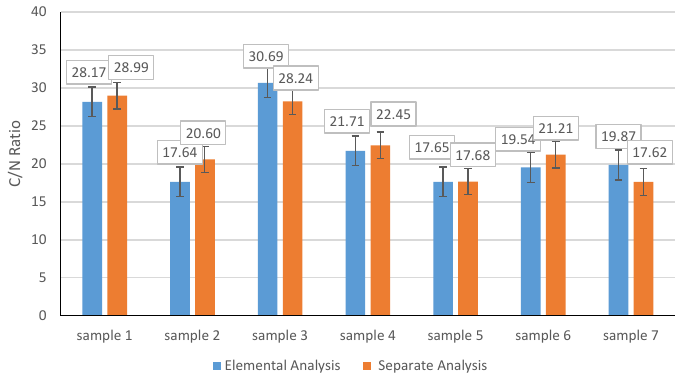
Fig. 2: Carbon to nitrogen ratio of food waste in different methods